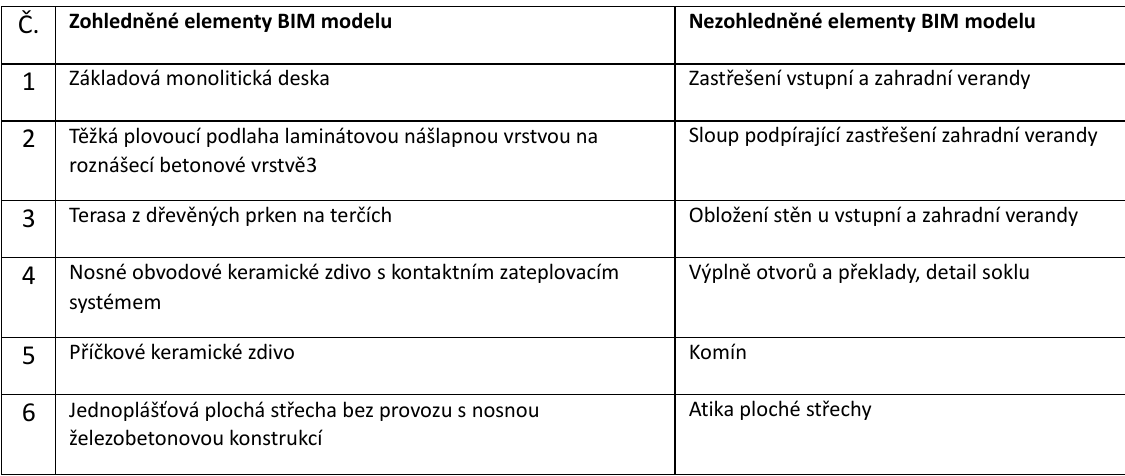
Tabulka 1: Zohledněné a nezohledněné elementy BIM modelu (zdroj: ČERNOVICKÝ, Vojtěch. Bakalářská práce. V Praze: ČVUT, 2020, str. 61)